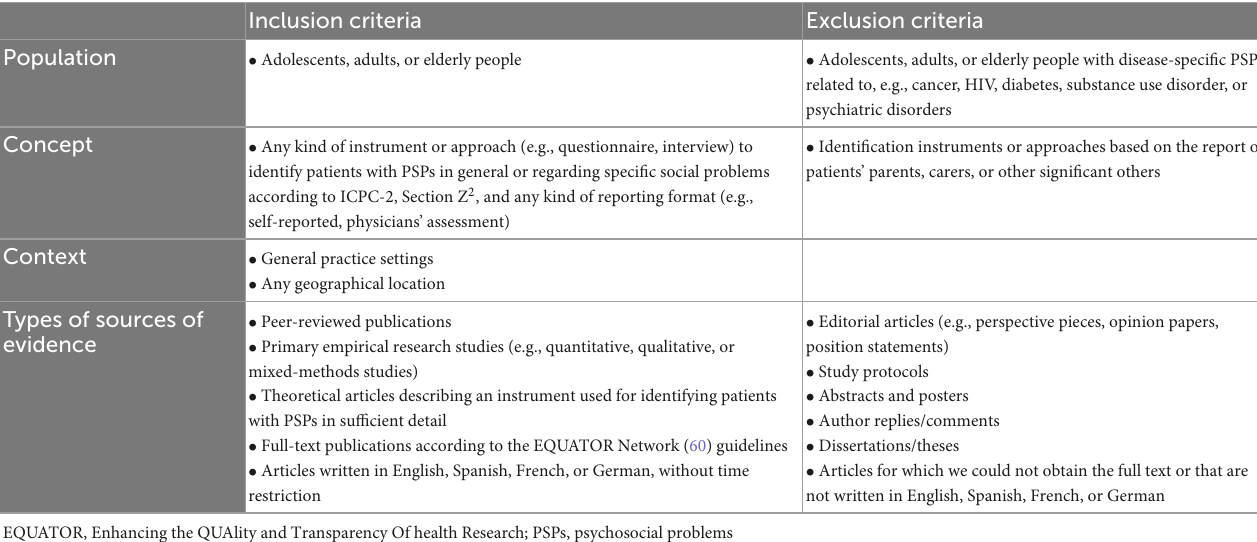
TABLE 1 Eligibility criteria based on study population, context, concept, and types of sources of